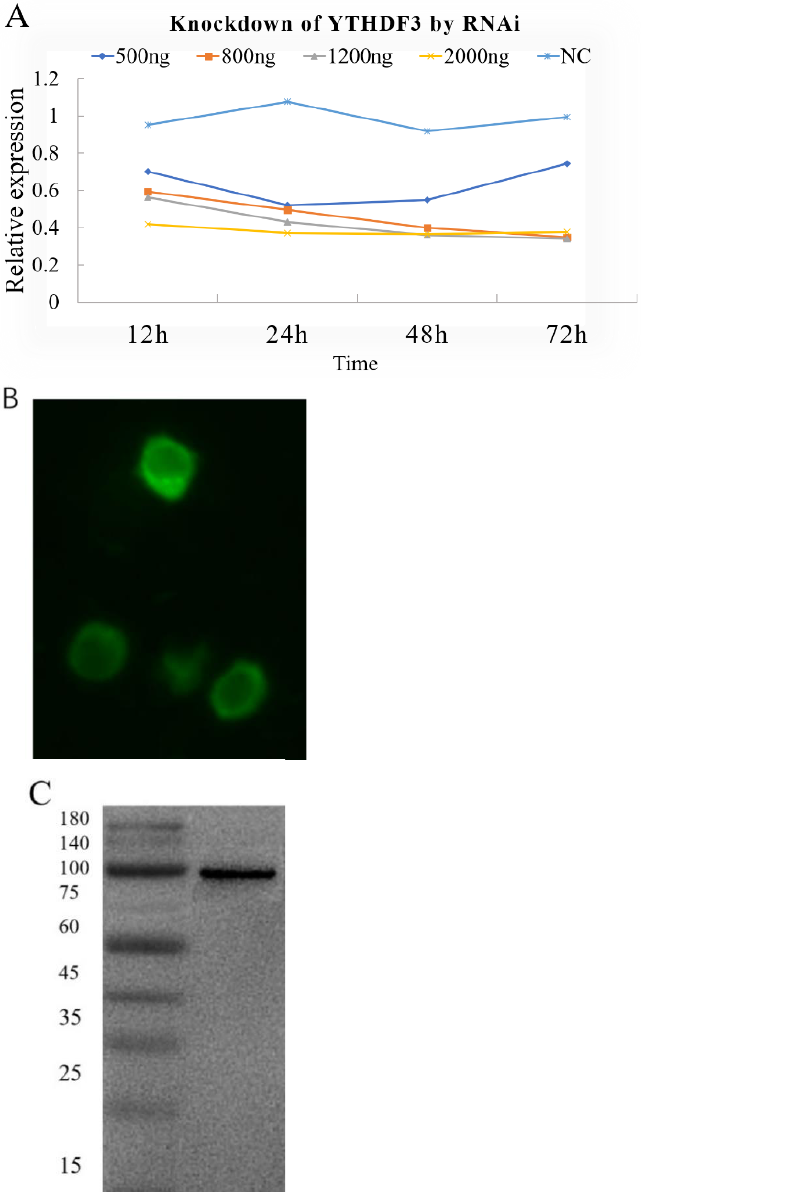
Figure 1. Knockdown and overexpression of YTHDF3 in BmN cells. ( A ) Knockdown of YTHDF3 by RNAi; ( B ) Overexpression and localization of BmBacJS13- egfp - YTHDF3 in BmN cells; ( C ) Western blotting of BmBacJS13- egfp - YTHDF3 .